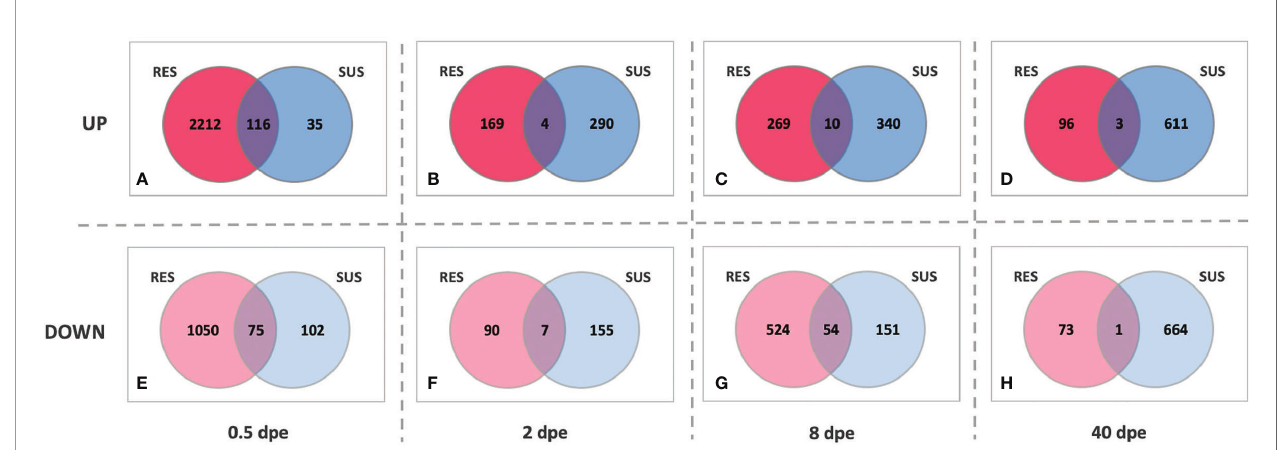
FIGURE 7 | Venn diagrams of comparisons between RES (red) and SUS (blue) snails exposed to S. mansoni for 0.5, 2, 8 or 40-days post exposure (dpe). Indicated for both strains at the various sampling time points are genes that are either up-regulated (top panel, A – D ) or down-regulated (bottom panel, E – H ) relative to unexposed snails of the same strain. The numbers in the areas of overlap indicate the particular genes that respond in the same direction in both snail strains.